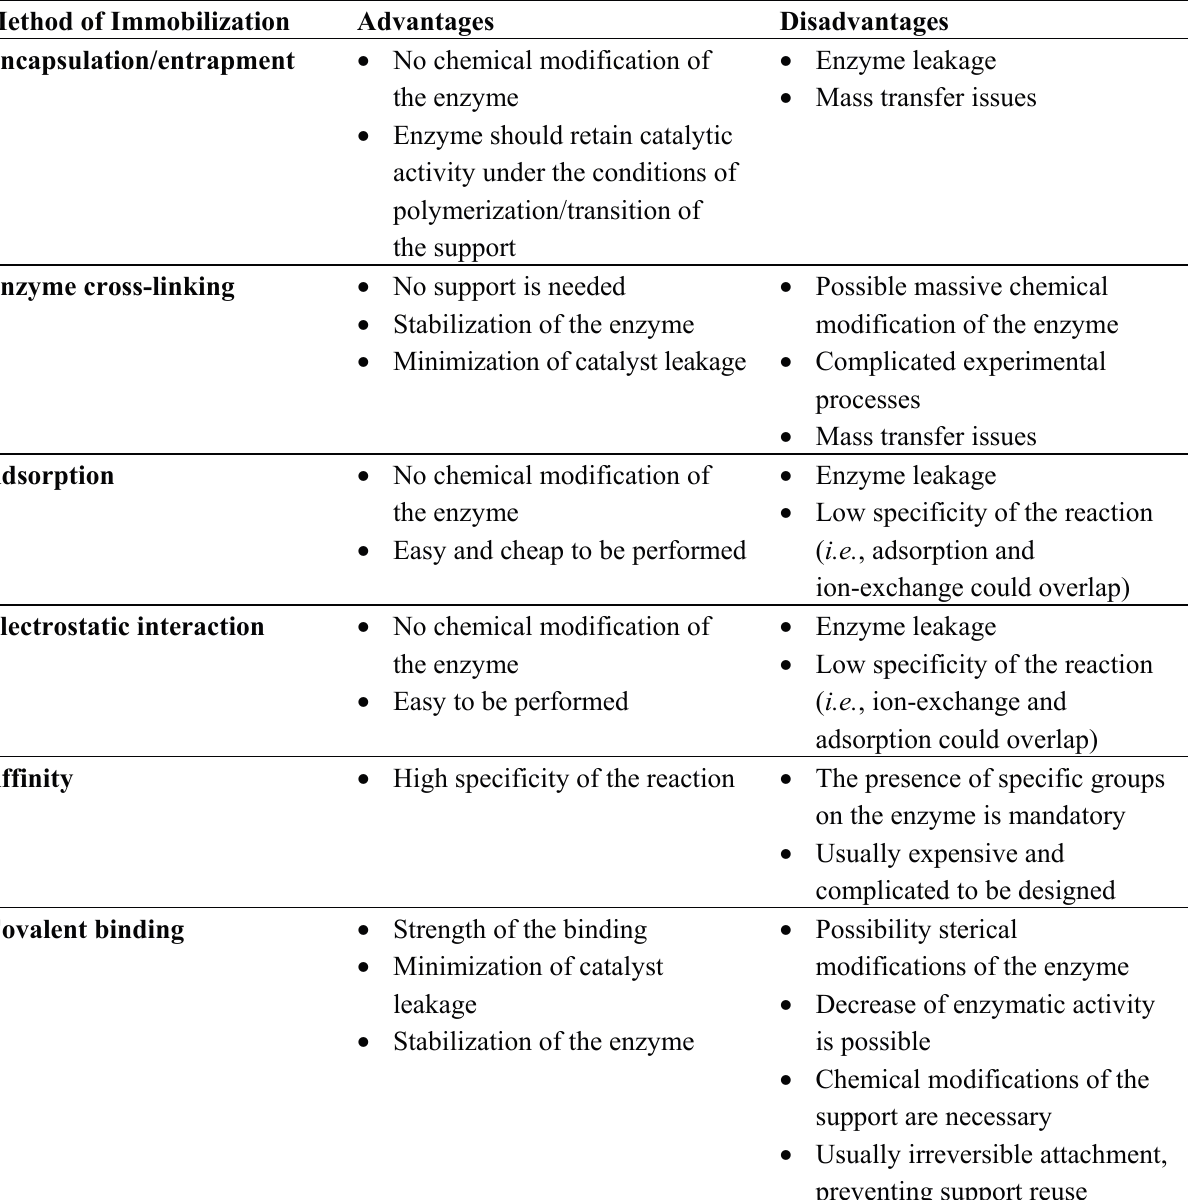
Table 1. Advantages and disadvantages of the most common methods of enzyme